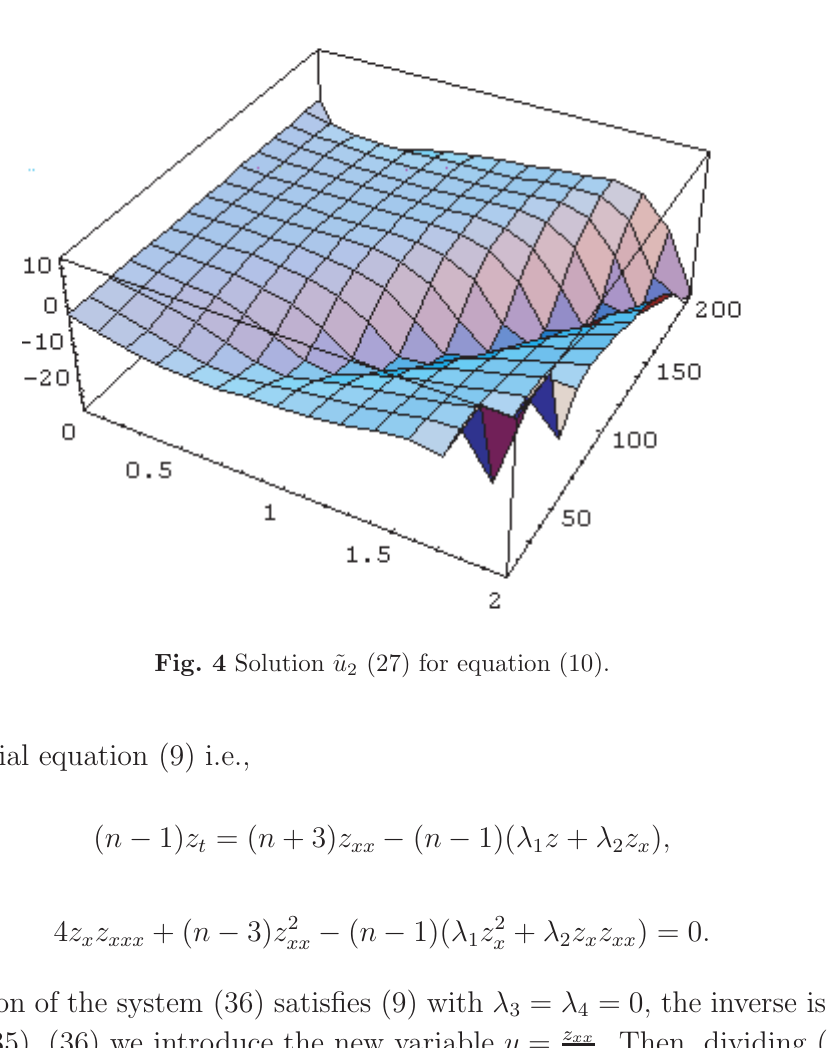
Fig. 3 Solution ˜ u 0 (27) for equation (10).